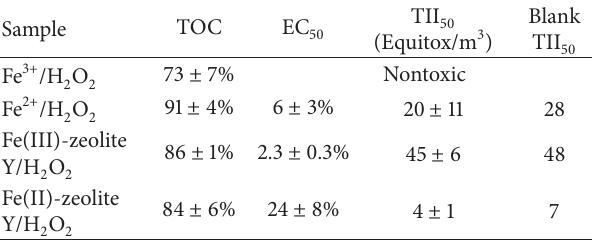
Table 1: Results for the mineralization and toxicity